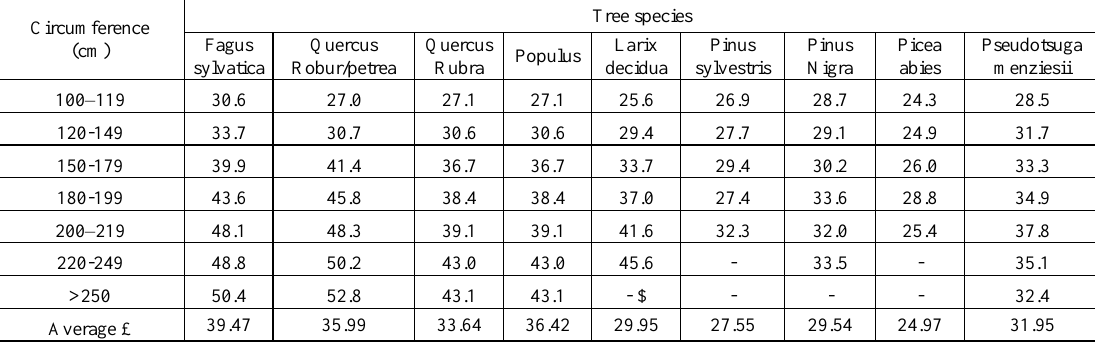
Table A2: Overview of timber values (€ per m³) sold as standing timber per circumference class for most important commercial tree